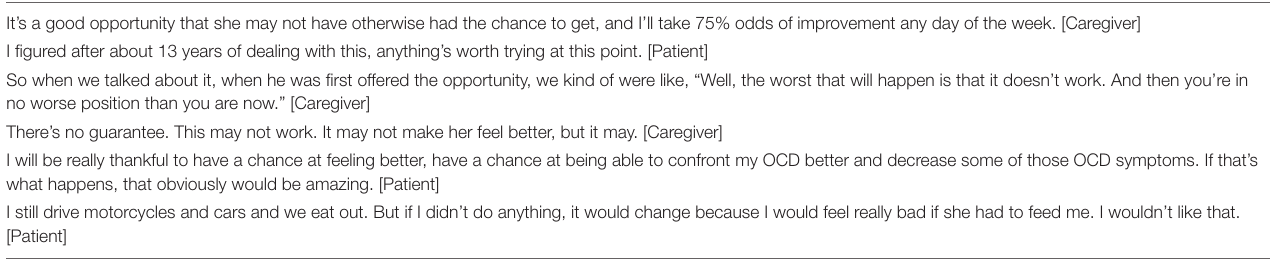
TABLE 5 | Hope for improvement of